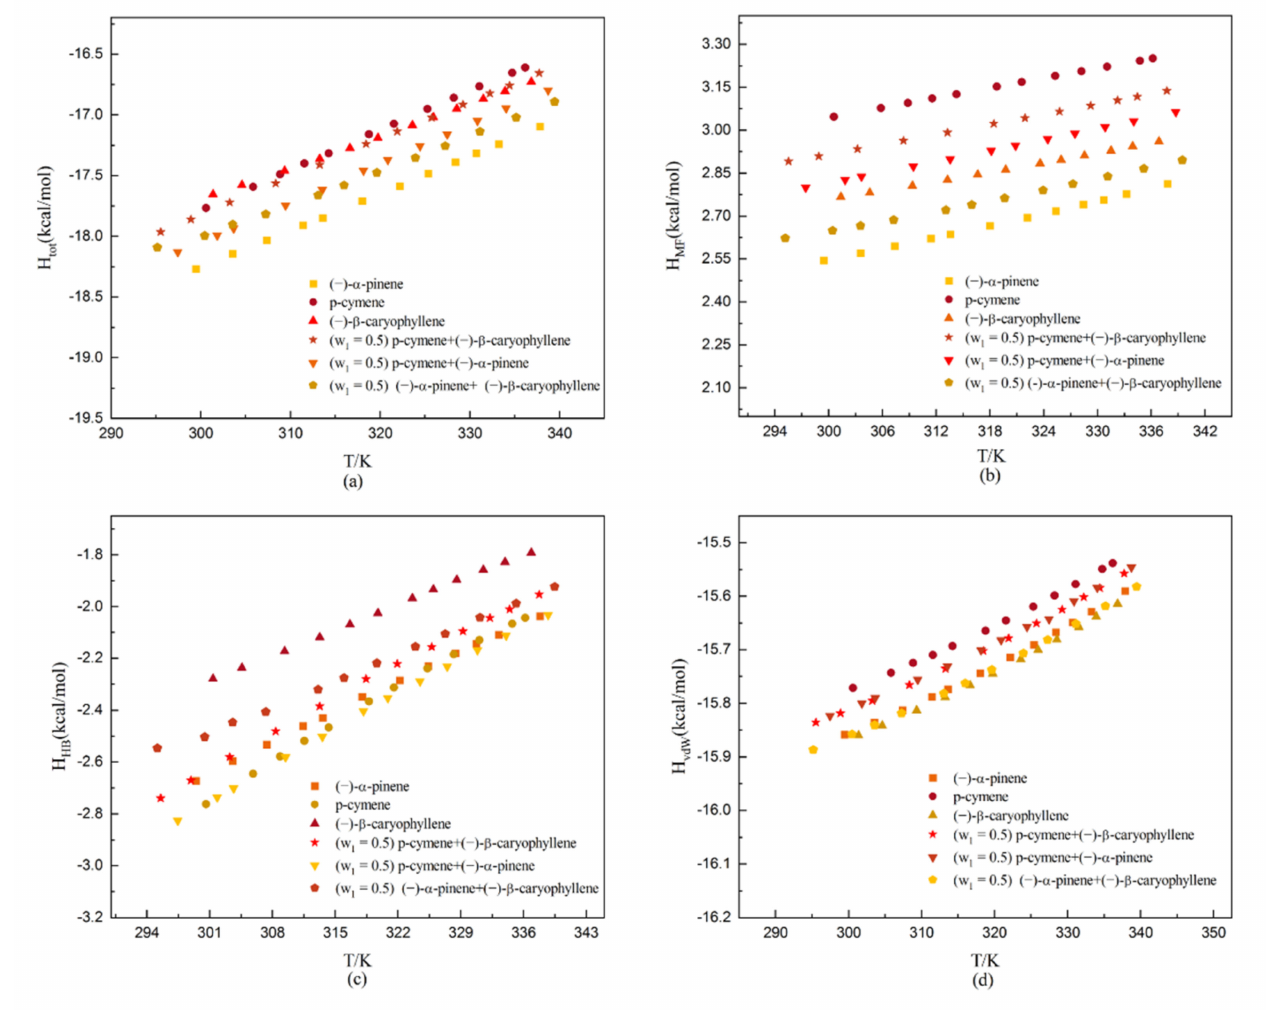
Figure 13. The molecular interaction energies of dehydroabietic acid in the studied solvents: ( a ) total mean interaction energy (H tot ); ( b ) misfit interaction energy (H MF ); ( c ) hydrogen-bond interaction energy (H HB ); and ( d ) van der Waals interaction energy (H vdW